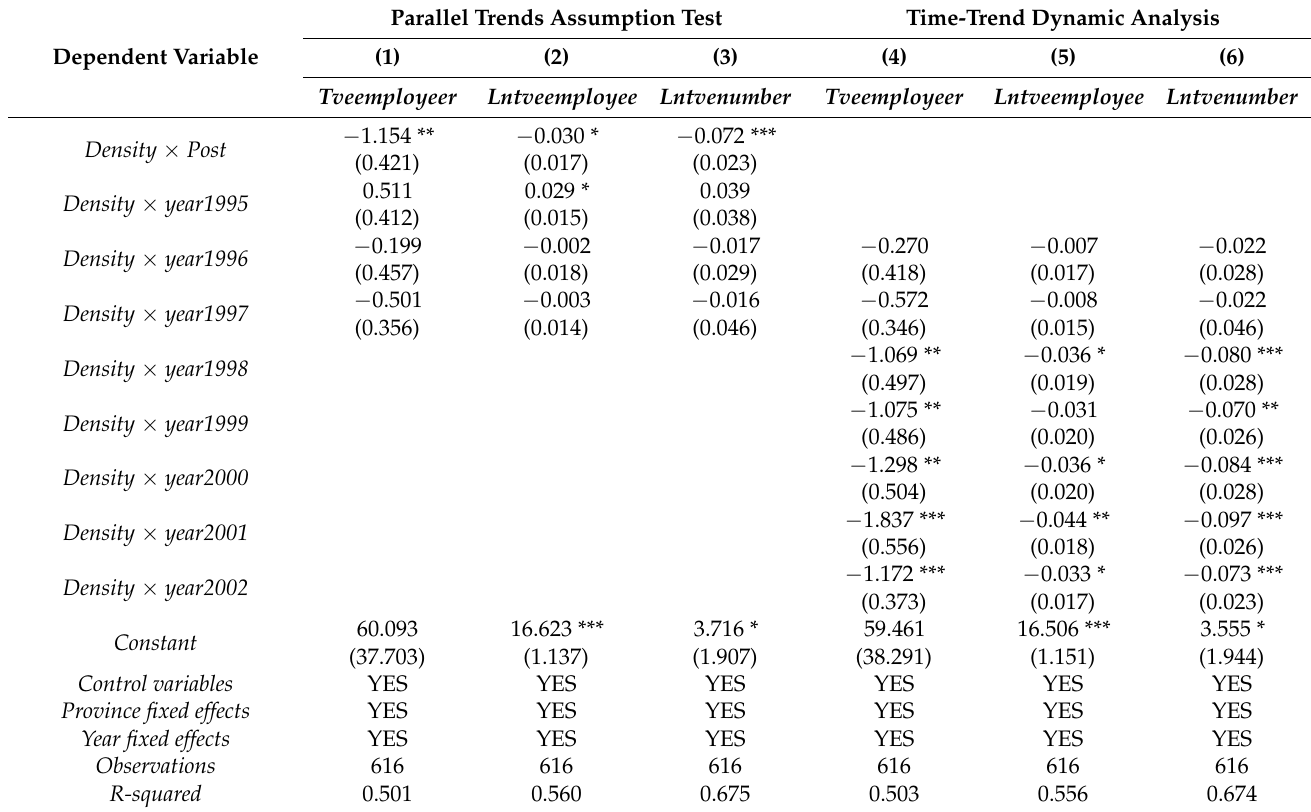
Table 8. Parallel trends assumption test and time-trend dynamic